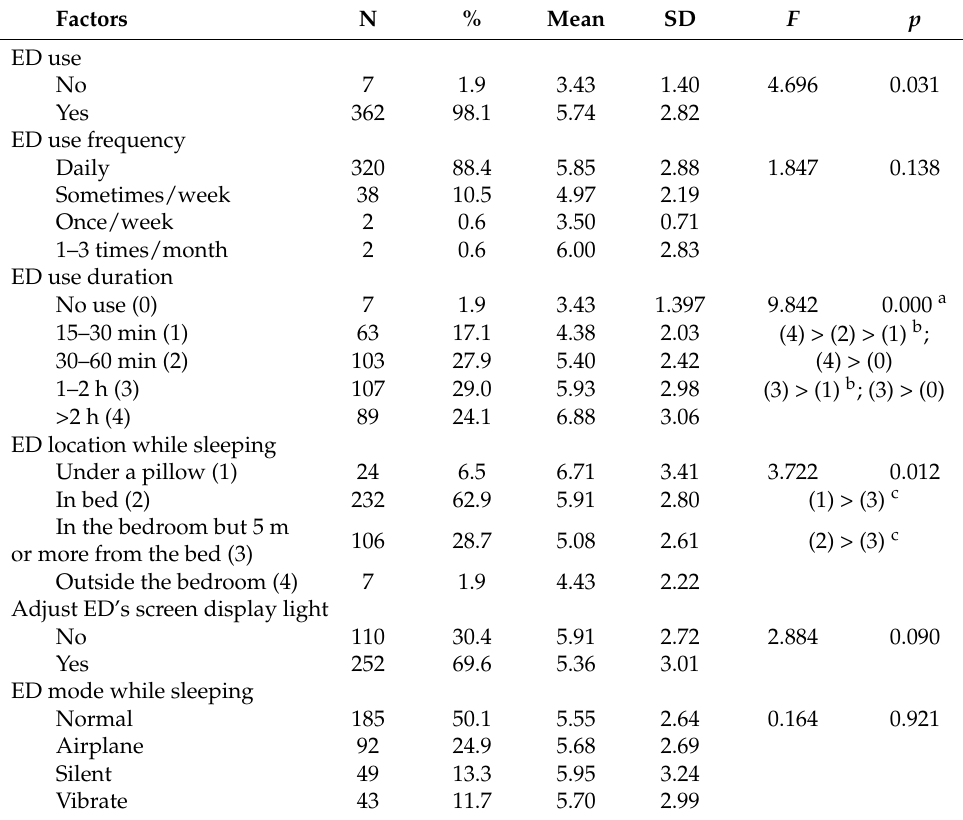
Table 3. ANOVA of ED-use behaviors on sleep quality (PSQI-V Score) (N =